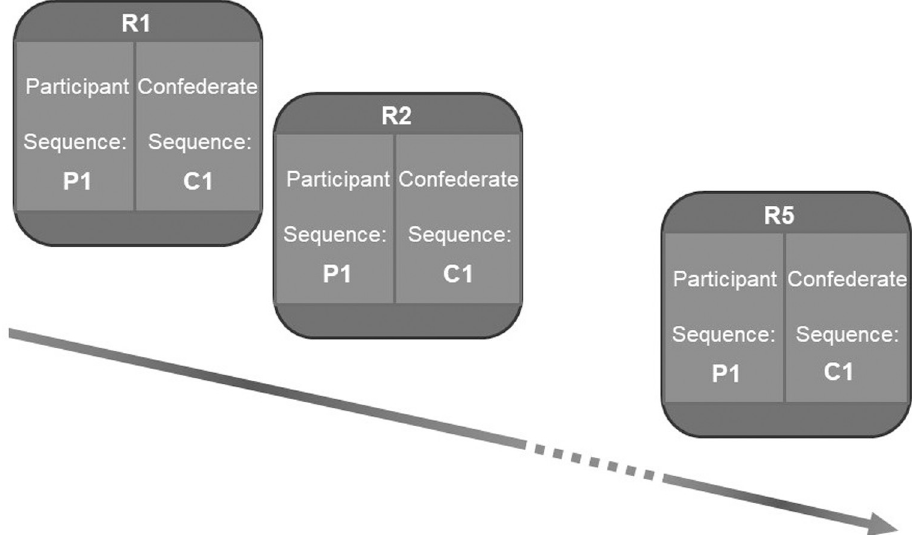
manipulated by making the participant repeat the same movement sequence (P1) across repetitions R1-R5, while the confederate also repeats her sequence (C1) across R1-R5, to produce completely predictable